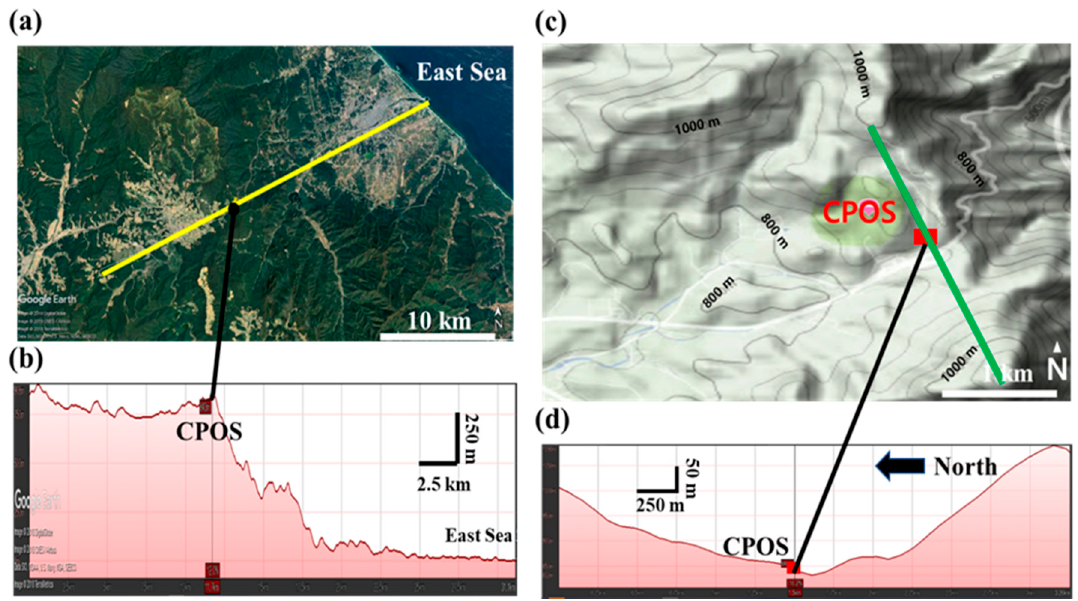
Figure 1. Maps of the measurement location: ( a ) areal map the indicates that the Cloud Physics Observation Site (CPOS) at Pyeongchang is 20 km southwest of the East Sea: ( b ) topographic profile along the yellow line in ( a ); ( c ) topographical map surrounding the CPOS, where height contours are plotted every 40 m, with thicker labelled contours every 200 m; ( d ) topographic profile along the green line in ( c ). The images in ( a , b,d ) are courtesy of Google Earth. Map of CPOS in ( c ) from: “Pyeongchang,